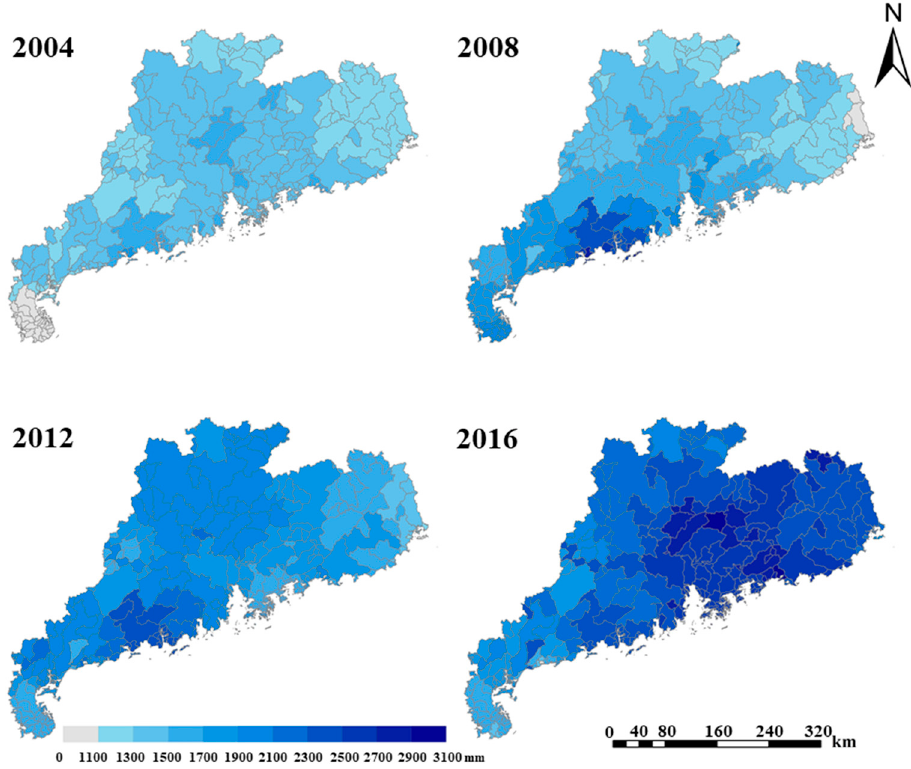
Figure 2. Spatial patterns of annual rainfall in Guangdong.